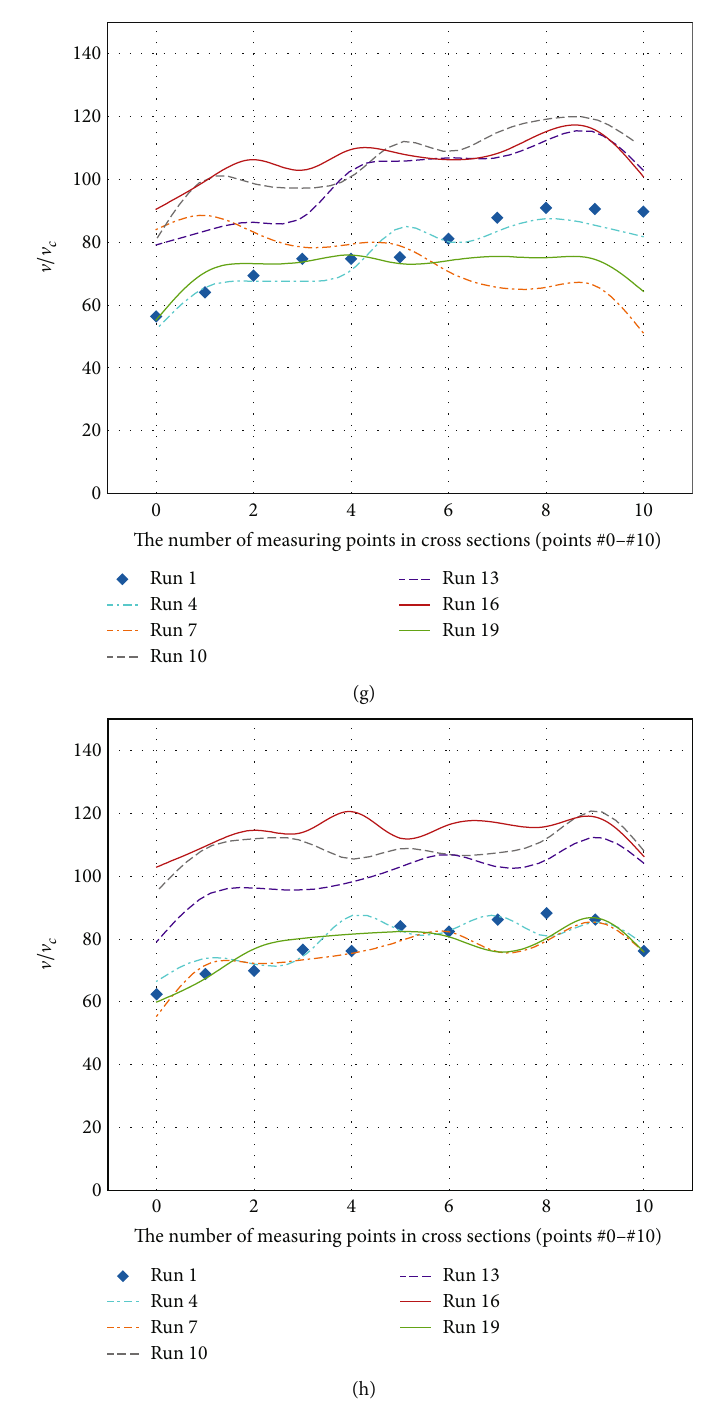
Figure 7: Typical cross-sectional velocity distribution of the spillway in the typical runs: Cross-sections (a) #4, (b) #7, (c) #10, (d) #13, (e) #16, (f) #19, (g) #22, and (h)